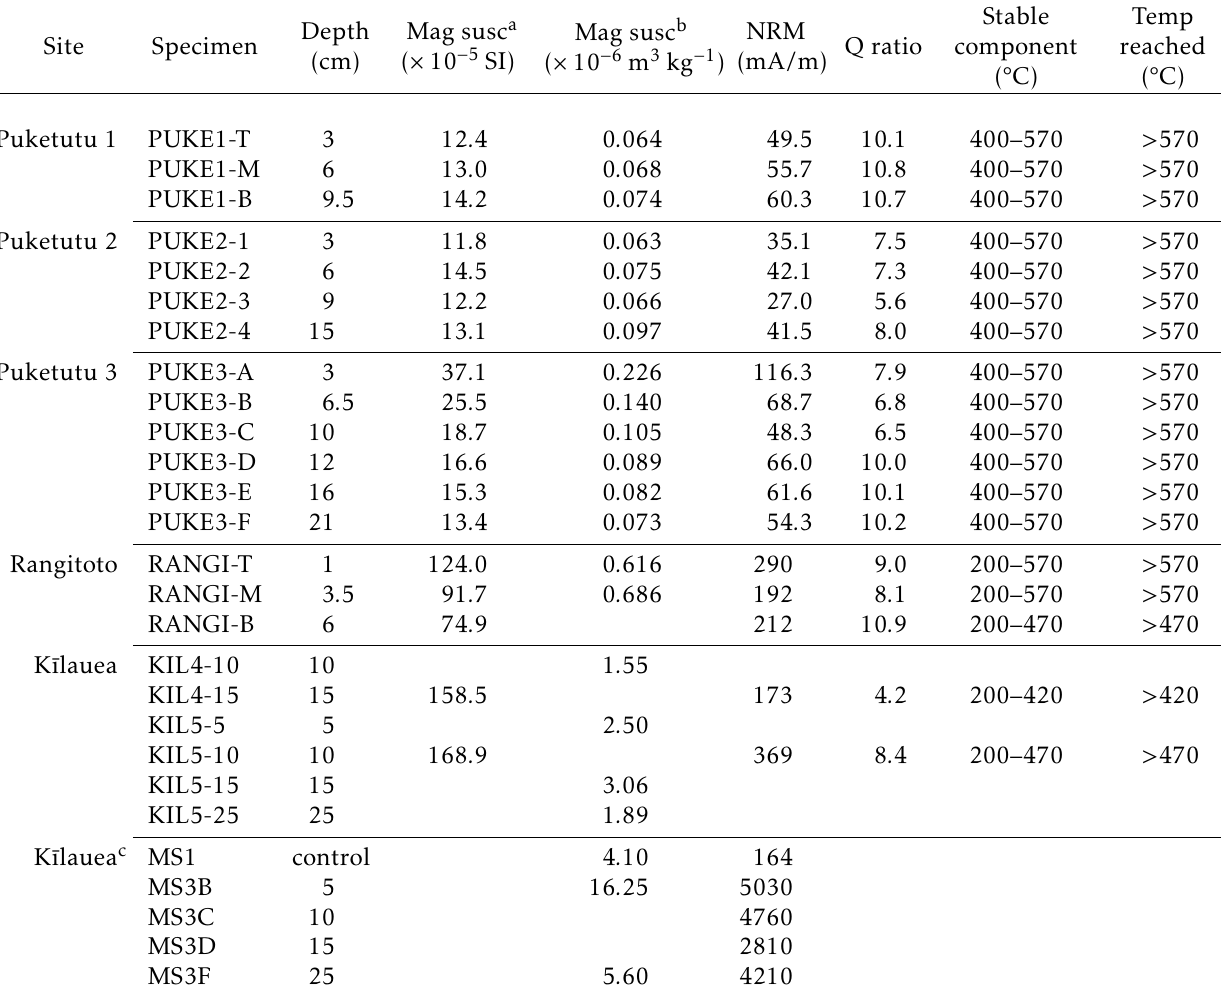
Table 1: Paleomagnetic